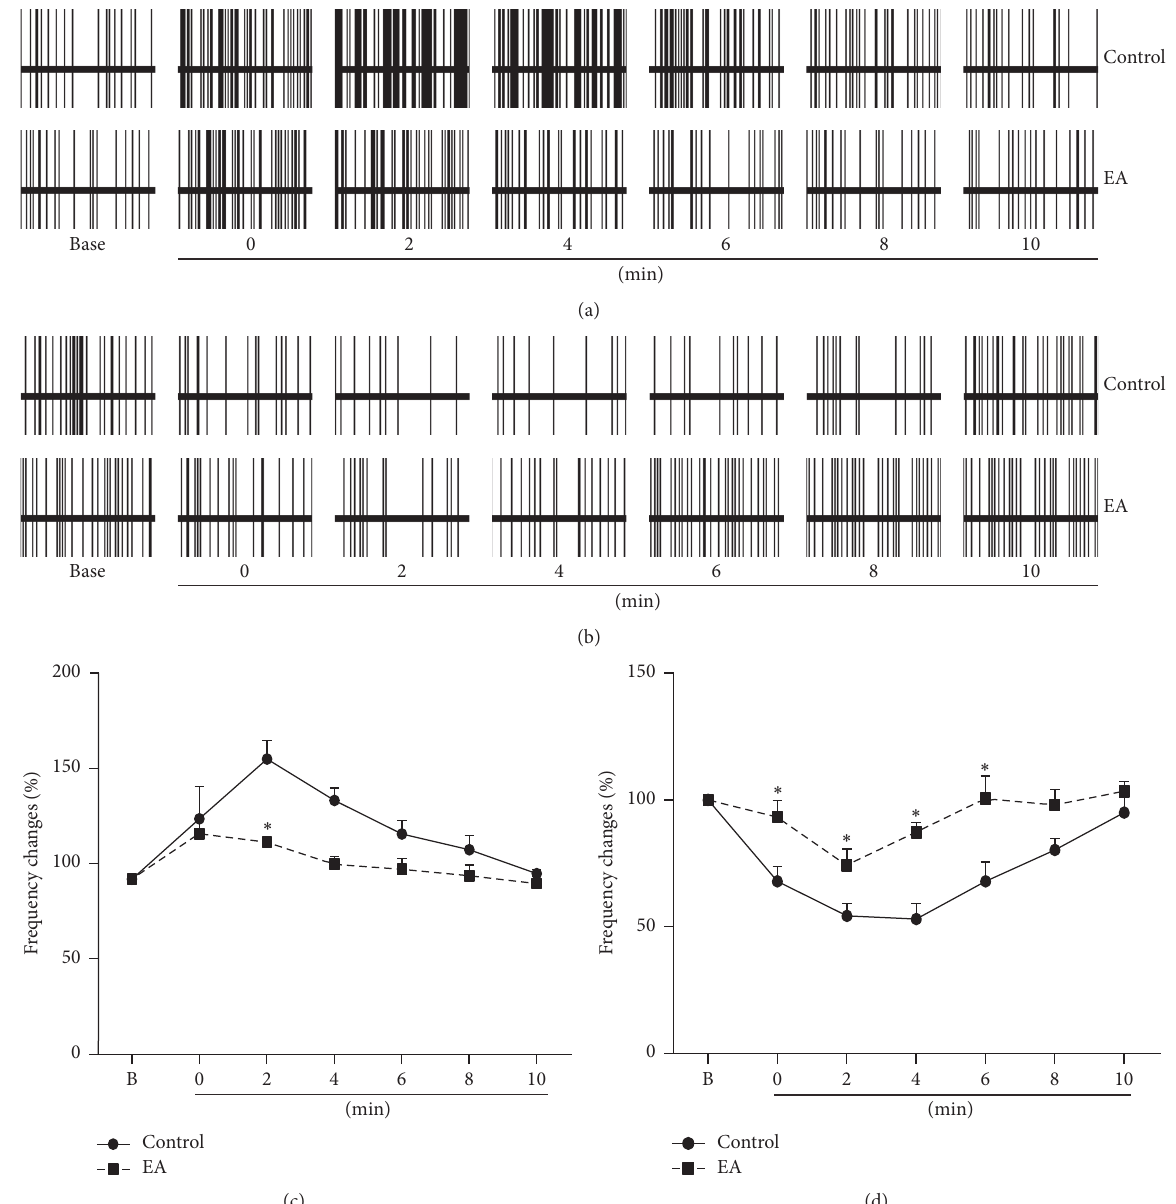
Figure 1: EA reduced the excitatory and inhibitory effects of brief sciatic nerve stimulation on the firing rates of PENs and PINs, respectively, in sham rats. (a) Example of EA reducing the effects of acute noxious stimulation on discharges of hippocampal PENs in the sham group. (b) Example of EA reducing the effects of acute noxious stimulation on discharges of hippocampal PINs in the sham group. (c) EA reduced the effects of acute noxious stimulation on the firing rates of hippocampal PENs ( 𝑛 = 17 ) at different times after the noxious stimuli in sham rats. (d) EA reduced the effects of acute noxious stimulation on the firing rates of hippocampal PINs ( 𝑛 = 12 ) at different times after the noxious stimuli in sham rats. The 10-second stimulation of the sciatic nerve occurred immediately before 0 min, not at 0min. B on the 𝑥 -axis stands for the background firing rate before the noxious stimulus. ∗ : compared with the control group, 𝑃 < 0.05